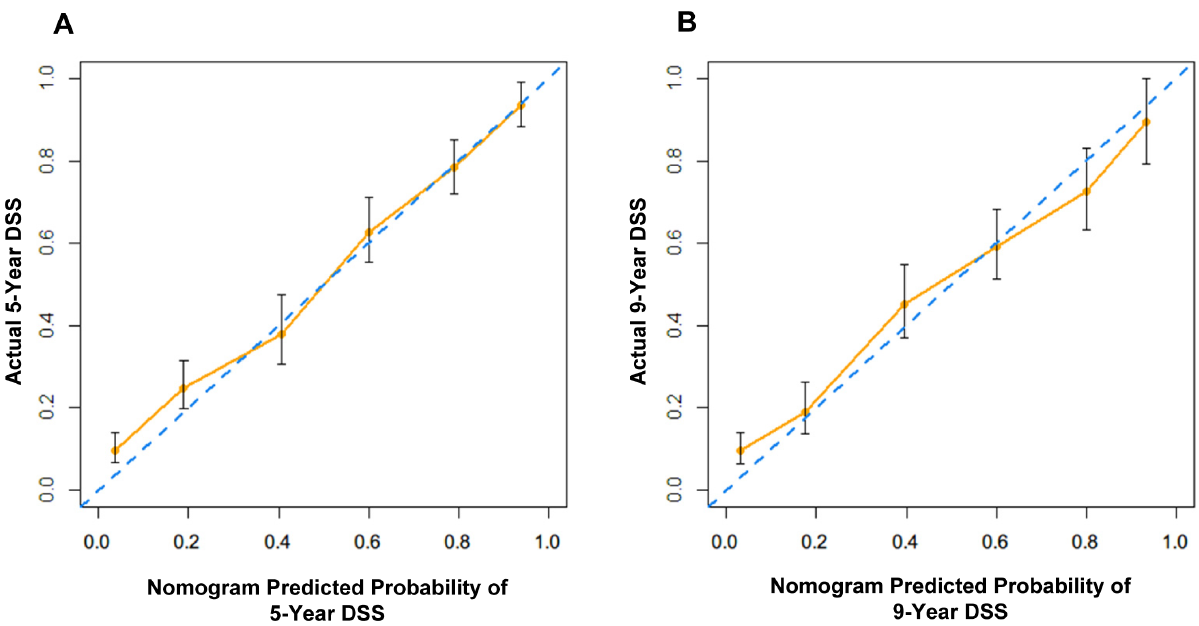
Figure 2. Calibration plots for the MSKCC nomogram in Chinese cohort. On the calibration plot, x-axis is the nomogram-predicted probability of DSS, and y-axis is the actual probability of DSS estimated by the Kaplan-Meier method. The dotted line represents the ideal nomogram; the solid line represents the performance of the MSKCC nomogram in Chinese cohort. (A) Five-year nomogram, (B) Nine-year nomogram.